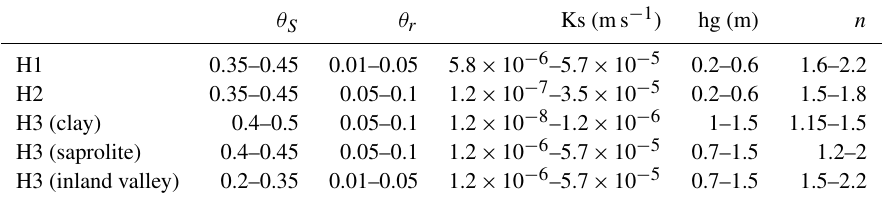
Table 1. Ranges of hydrodynamic properties in the area, following Van Genuchten (1980). From Hector